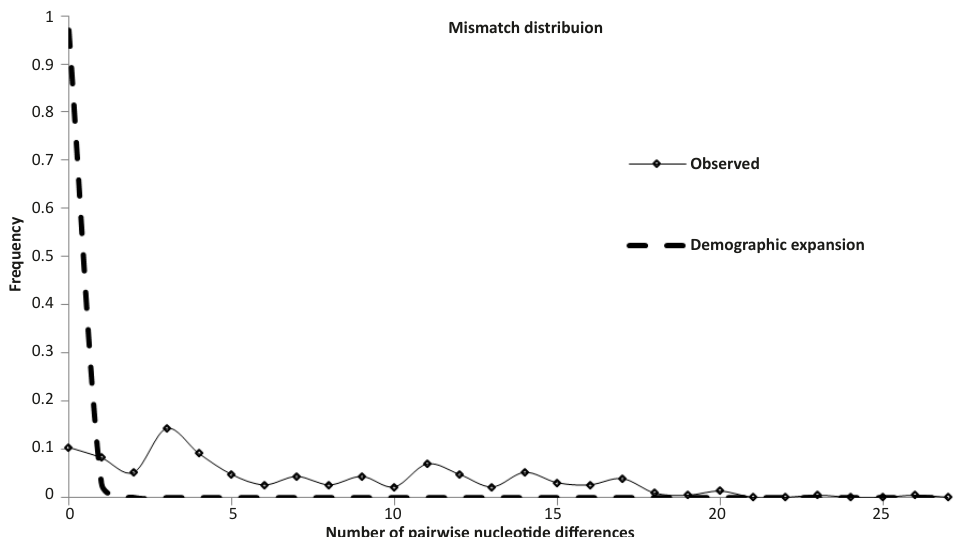
Figure 4. Mismatch distribution analysis for the mitochondrial control region of the Philippine Eagle.